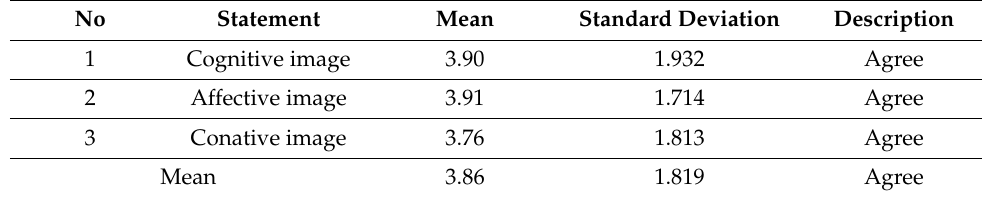
Table 2. Tourist Destination Image (TDI) Descriptive